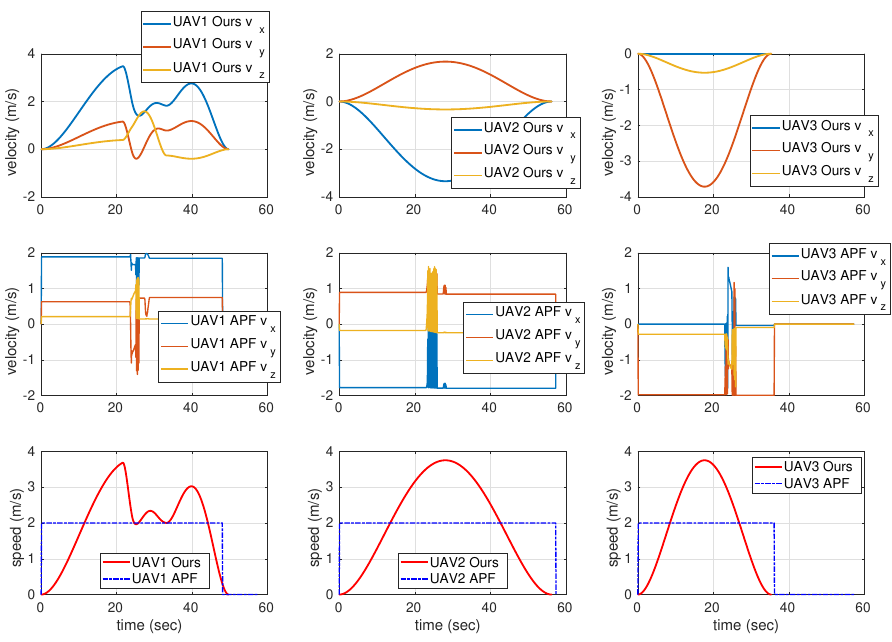
Figure 16. Linear velocities and speeds of each UAV in the case of only dynamic obstacles.